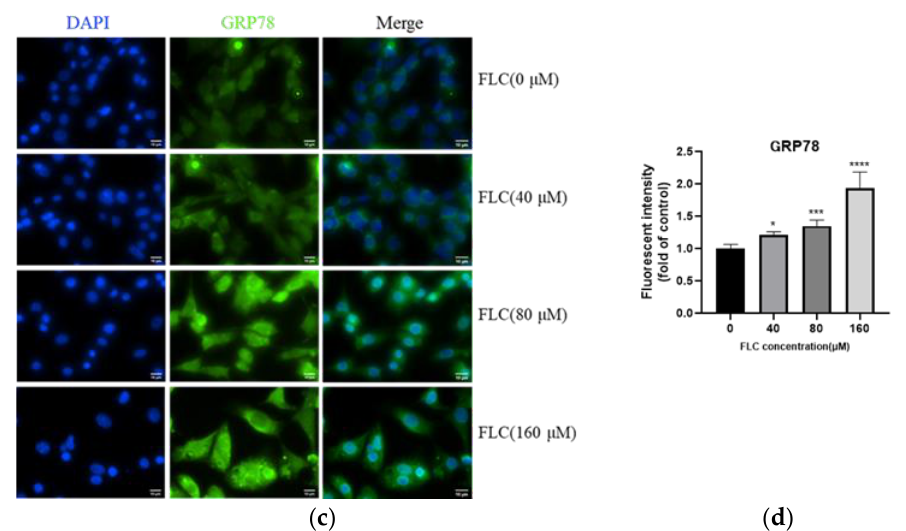
Figure 3. FLC induced Endoplasmic Reticulum (ER) stress and activated Unfolded Protein Response (UPR) signaling pathways. TM4 cells were treated by FLC at the concentrations of 0, 40, 80, 160 μM for 6, 12, 24 h. ER stress and UPR related protein levels were determined by Western Blot with indicated antibodies. ( a ) The representative blots were shown; ( b ) The quantitative data was analyzed by ImageJ and GraphPad Prism software. GRP78 protein level were detected by immunofluorescence staining in green and the nuclear was stained with DAPI in blue; ( c ) The representative images of GRP78 (Magnification, 400 ×; scale bar, 10 μm) were shown; ( d ) The quantitative data was analyzed by ImageJ and GraphPad Prism software. * p < 0.05, ** p < 0.01, *** p < 0.001, **** p < 0.0001 vs. control group (0 μM FLC), n = 6.